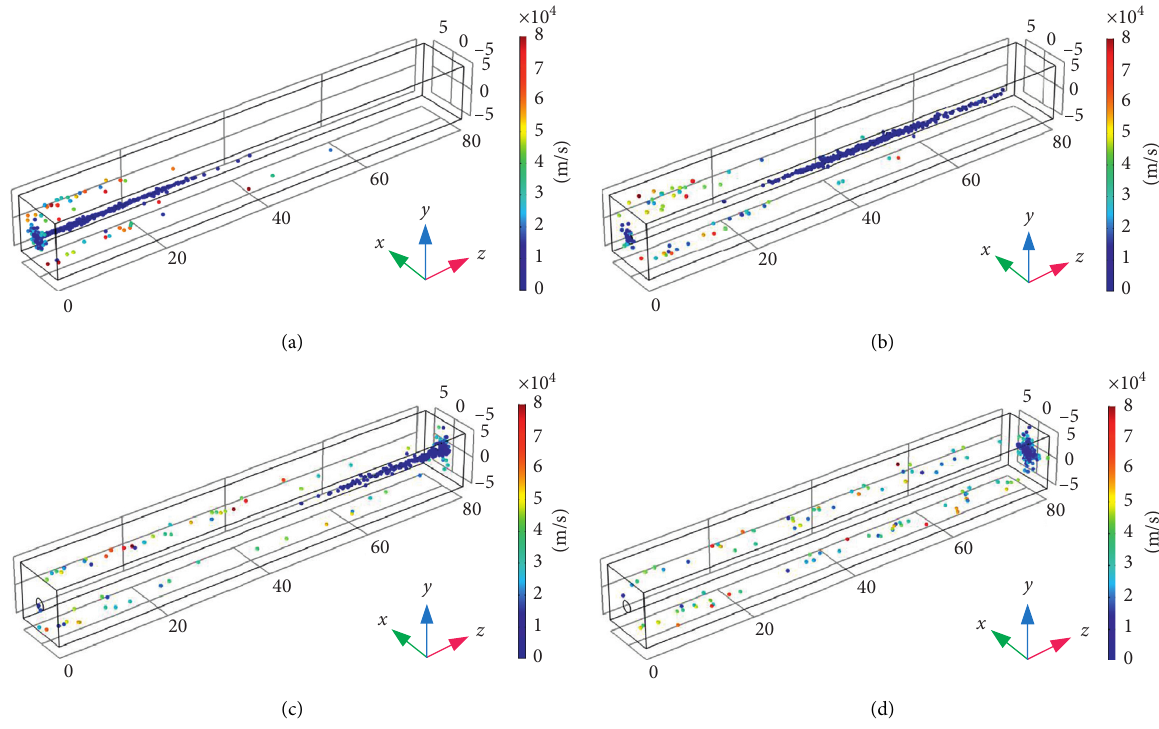
Figure 5: Ion states at the end of the simulation under different gas flow rates when the pressure was 150Pa: (a) V min, (c) V 0 � 4L/min, and (d) V 0 � 6L/min.